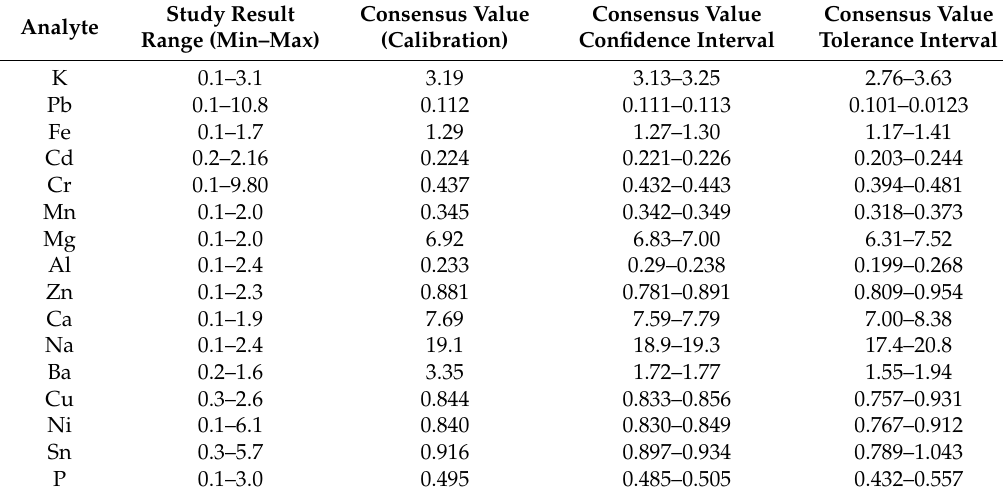
Table 2. ICP-OES analytes confidence and tolerance intervals. Data provided via academic related technical services standards for the SUERC ICP-OES facility used in this thesis. All values are in parts per million (ppm). The ICP-OES was calibrated for pollutant concentrations of 0.1 ppm to 10